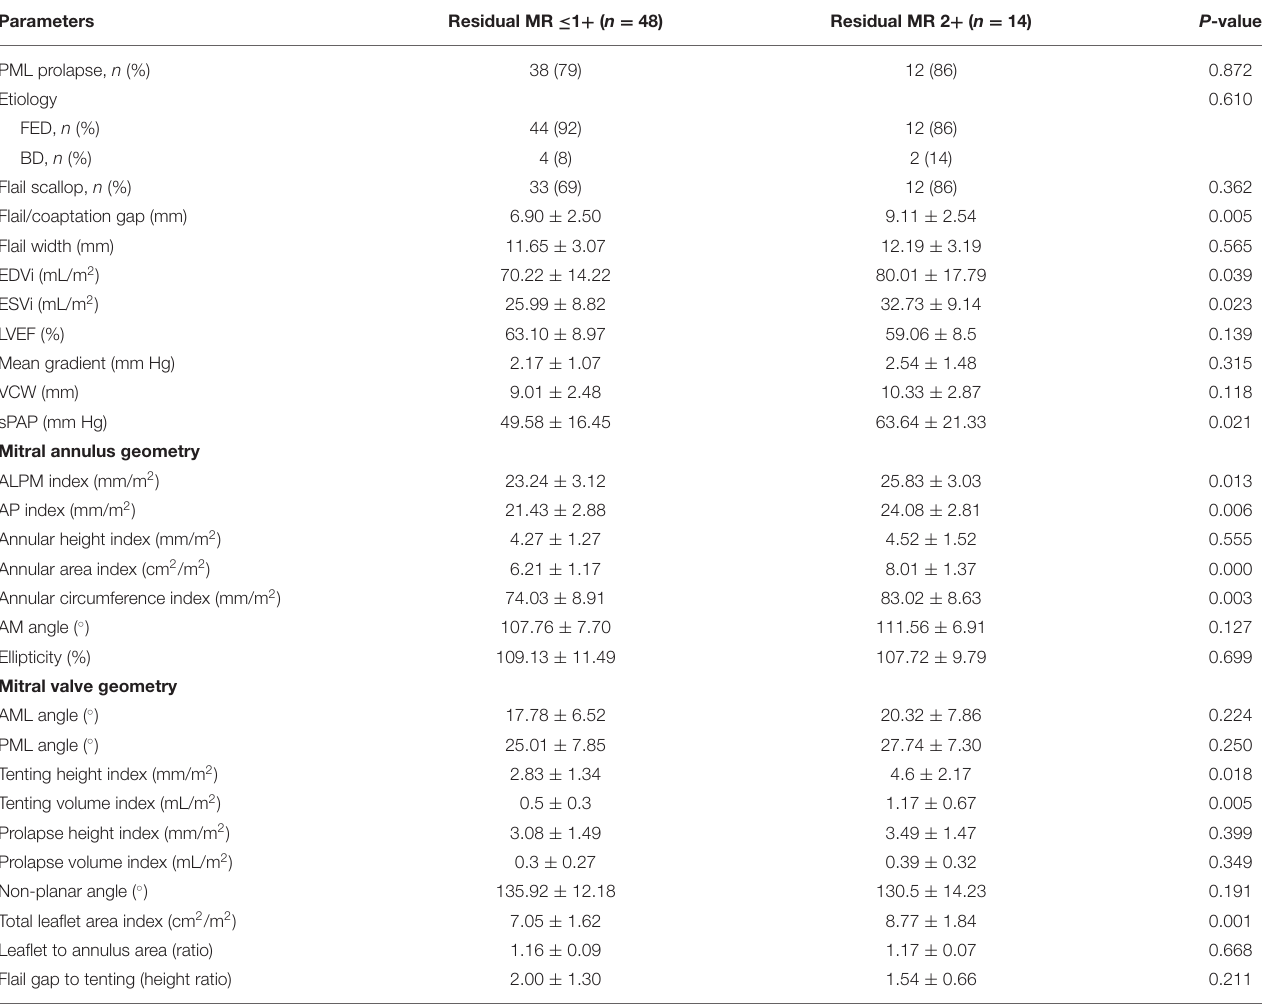
TABLE 2 | Anatomic and hemodynamic characteristics.